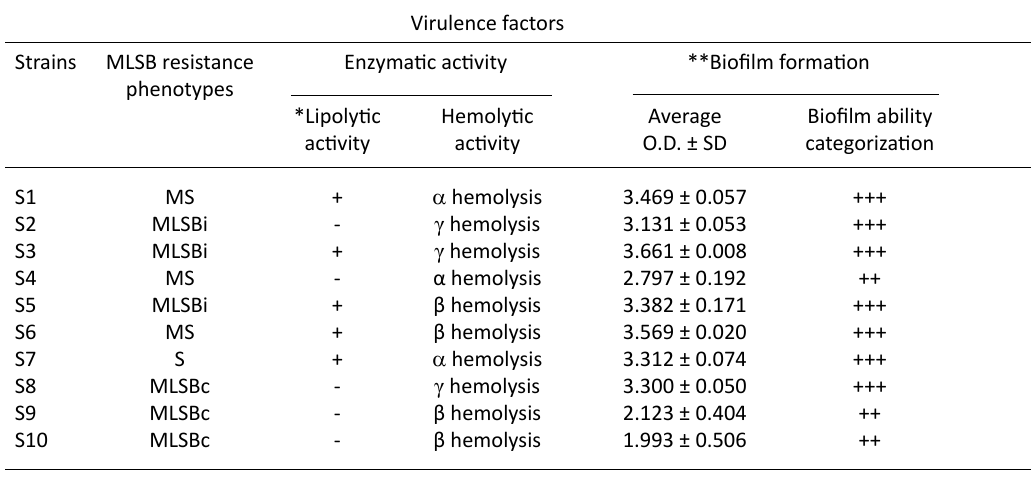
Table 2. Virulence factors and resistance phenotypes assessment among S. aureus stains.